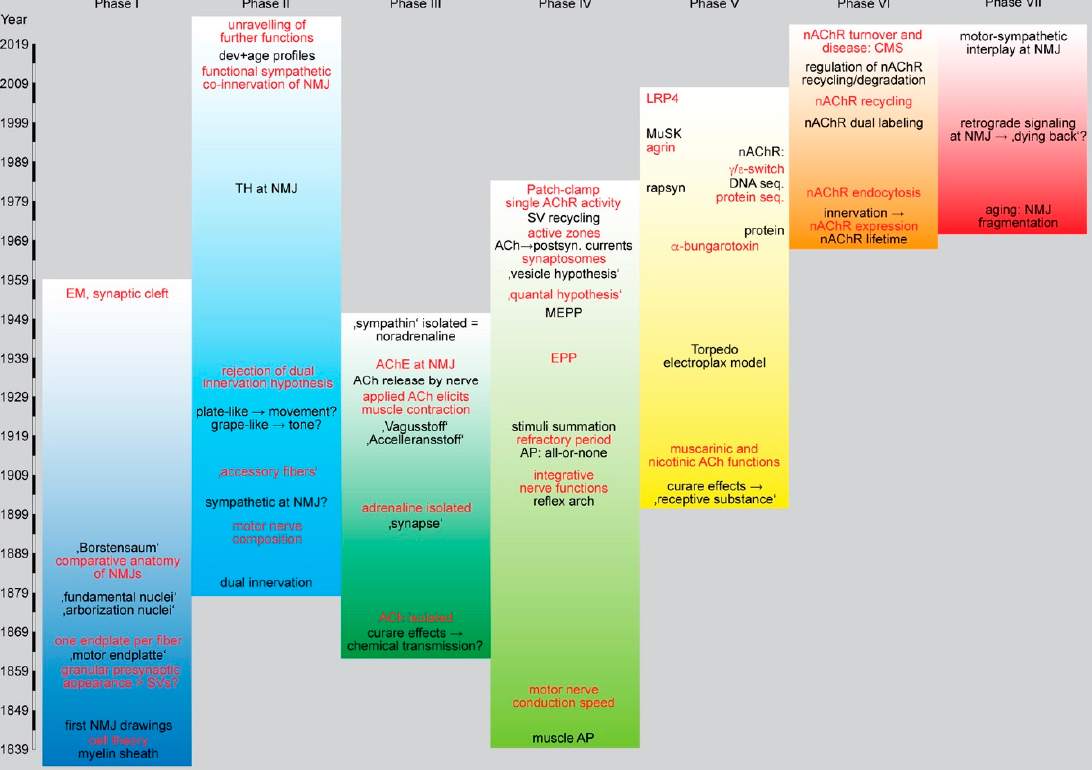
Figure 2. Schematic overview of the different phases of NMJ studies. This scheme highlights major aspects of research on NMJ.